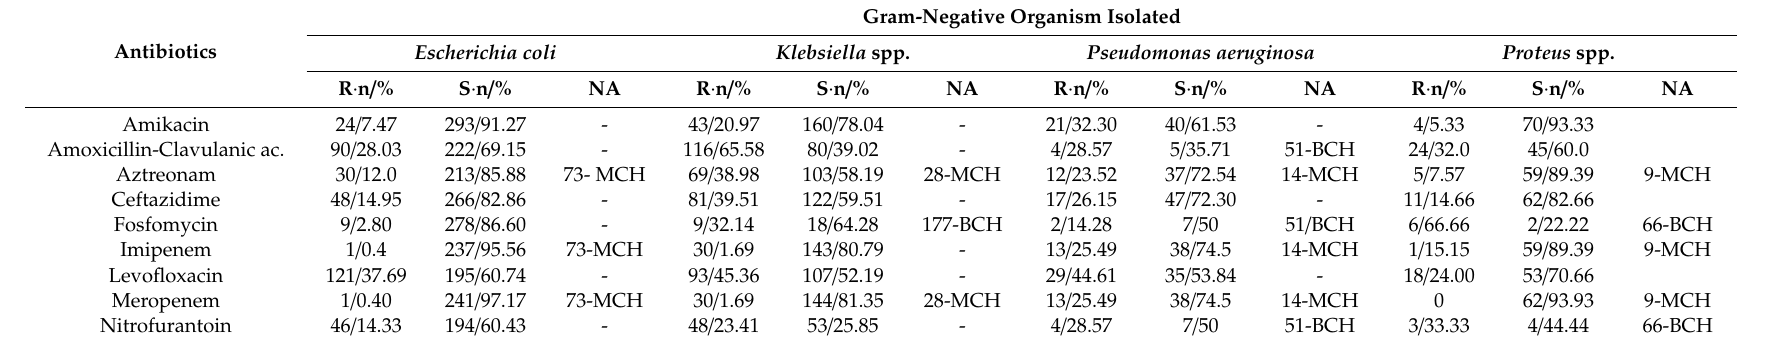
Table 3. Overall antibiotic resistance profile in Gram-negative